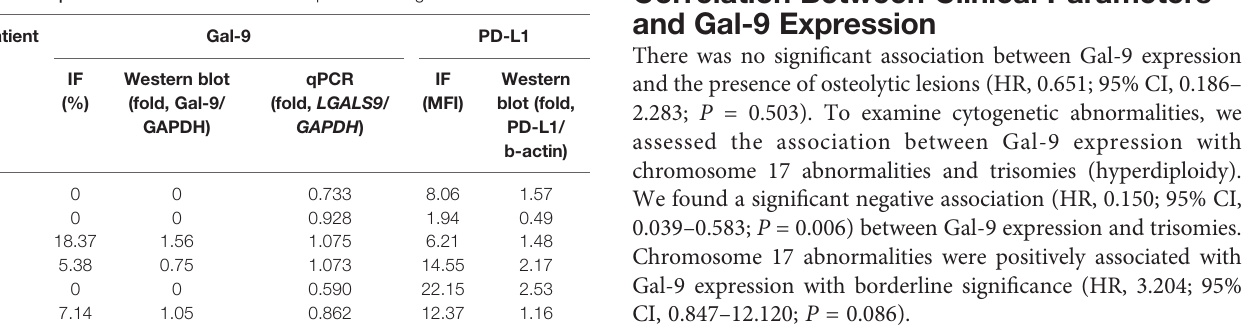
IF, immuno fl uorescence; MFI, mean fl uorescence intensity; qPCR, quantitative real-time